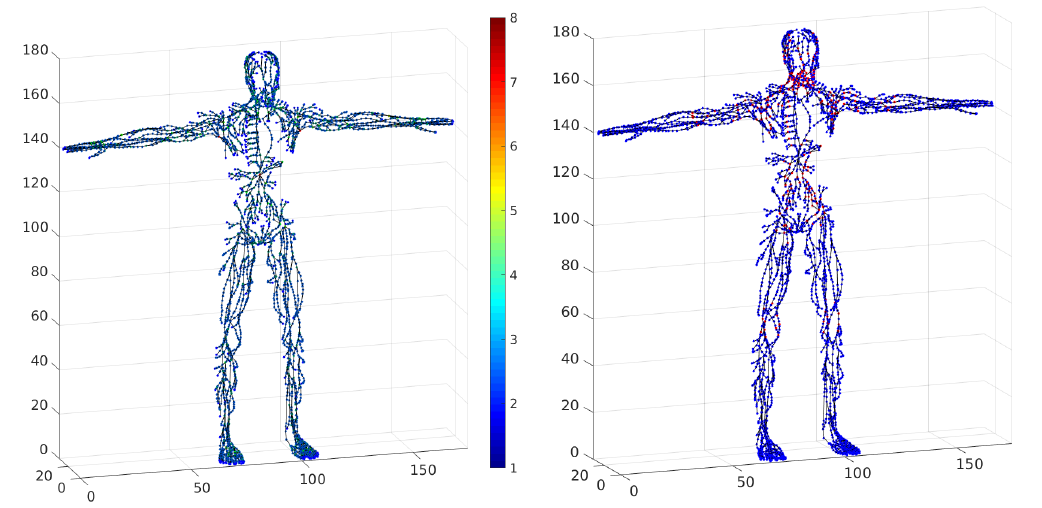
Figure 11. The body-wide distribution of the vertices degrees in the basis network graph. ( Left ) deg = 1 for the inputs and outputs of the system, deg = 2 for the inner point of the vessel, deg ≥ 3 for vessel junctions; ( right ) vertices of the basis graph representing the lymph nodes are marked in